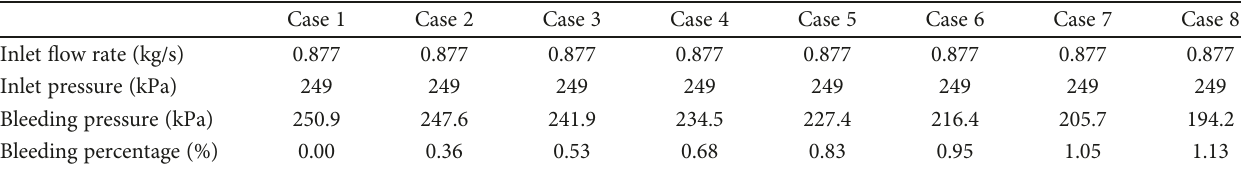
/ H = 1 73, T = 150 ° C ). 2 1